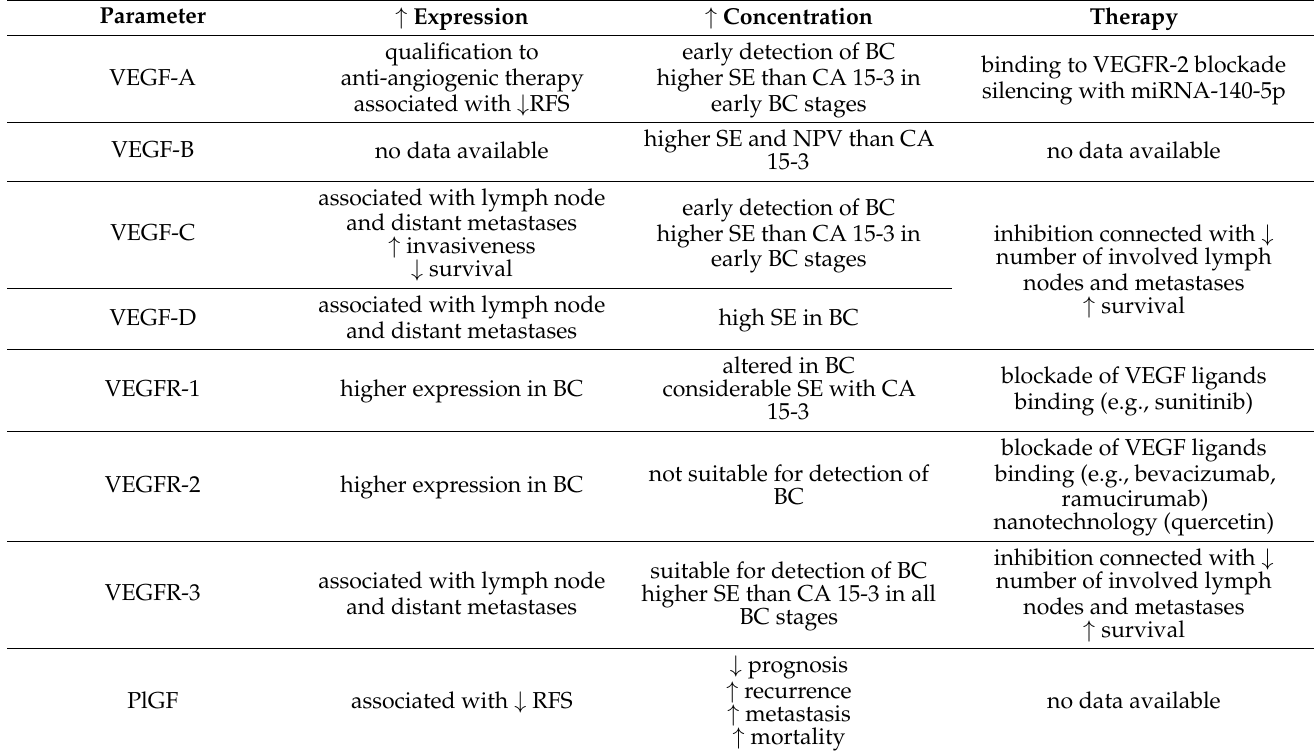
Table 2. The summary of VEGF ligands and receptors usefulness in detection and therapy of